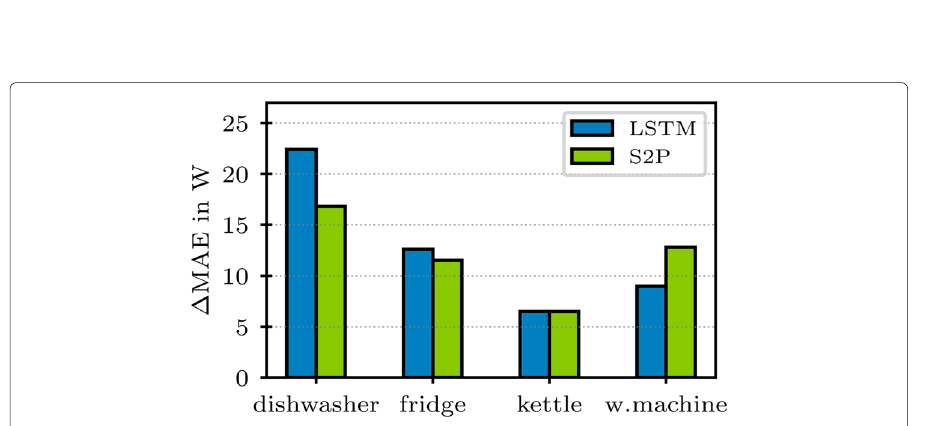
Fig. 5 Performance gap with regard to MAE for REFIT house